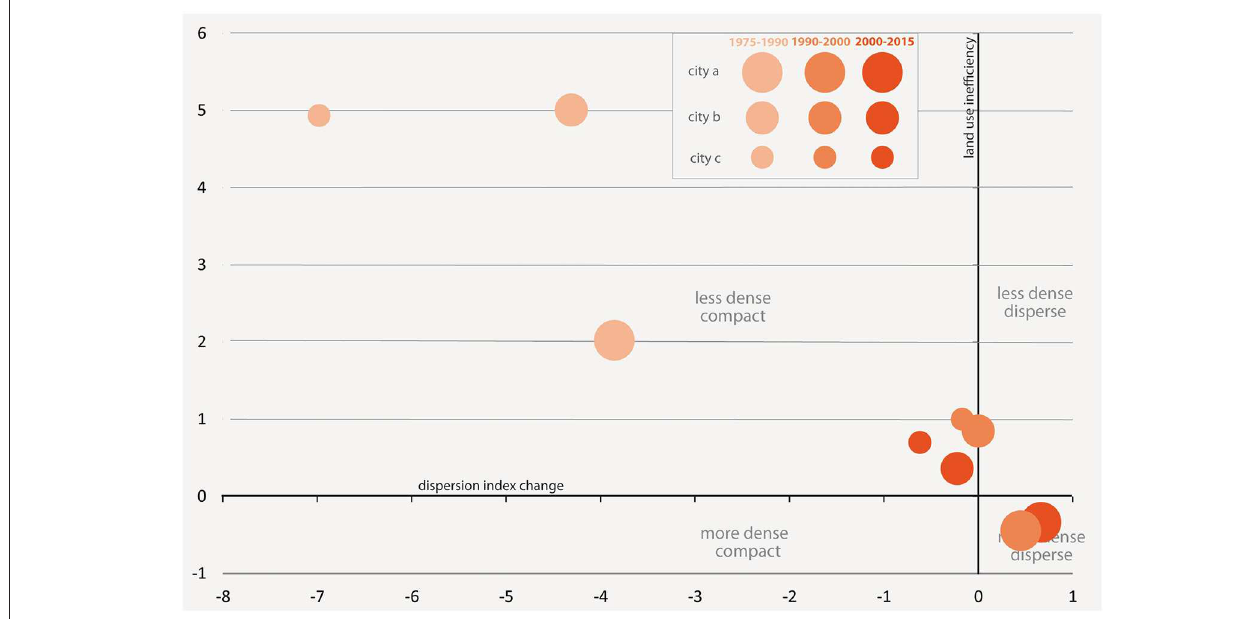
FIGURE 5 | Urbanization trends by city size.